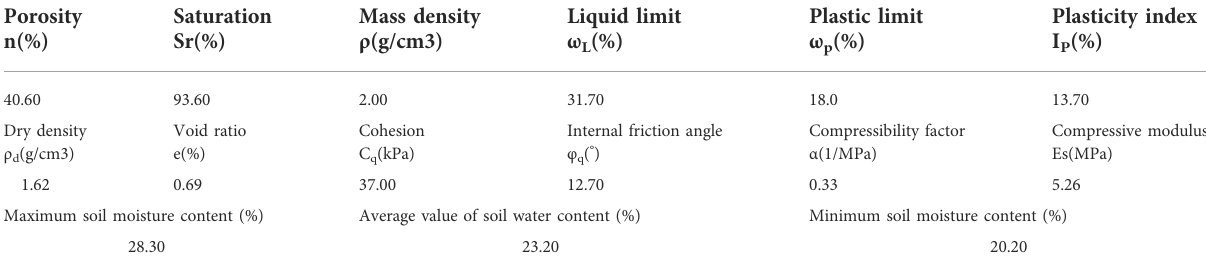
TABLE 1 Basic physical properties of natural silty